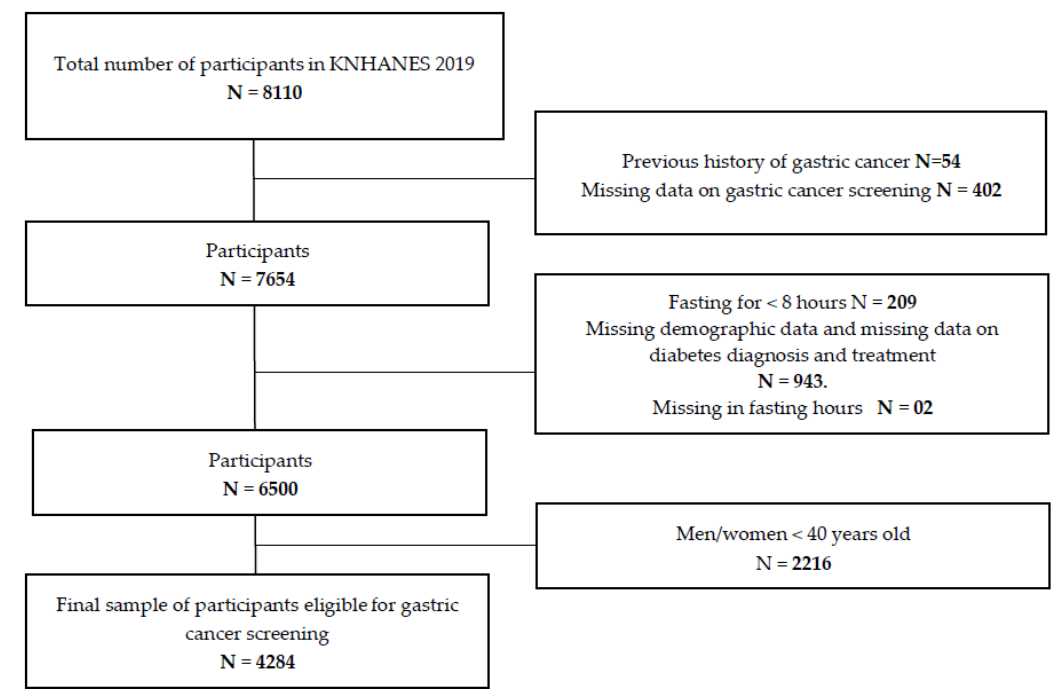
Figure 1. Flow chart describing gastric cancer screening sample selection.